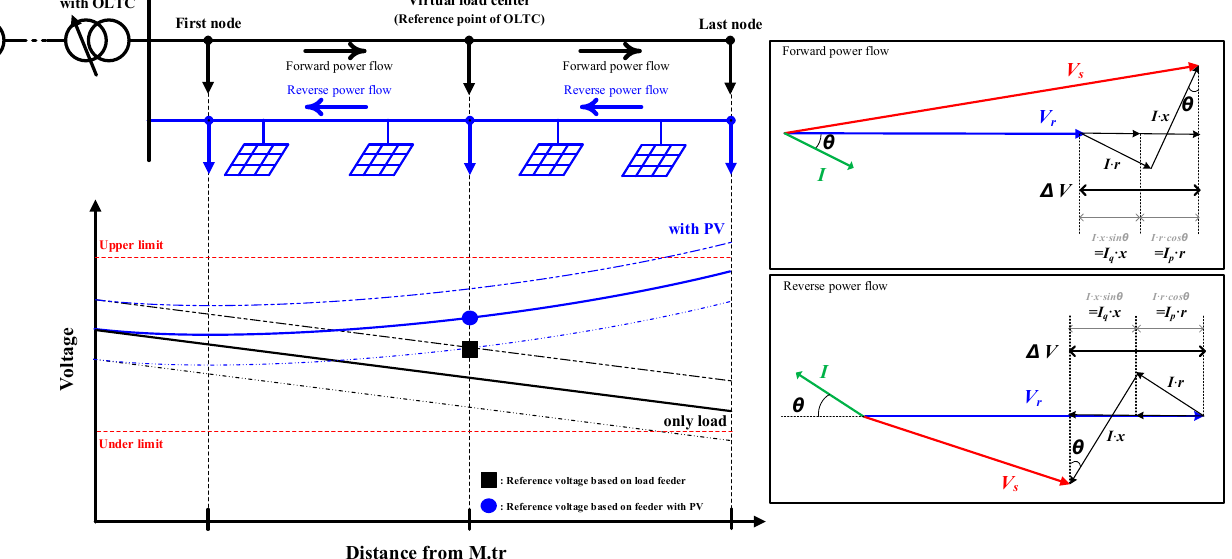
Figure 3. Voltage of feeders based on the reference point and voltage of the OLTC operation. Table 1. Operating voltage of the distribution system in